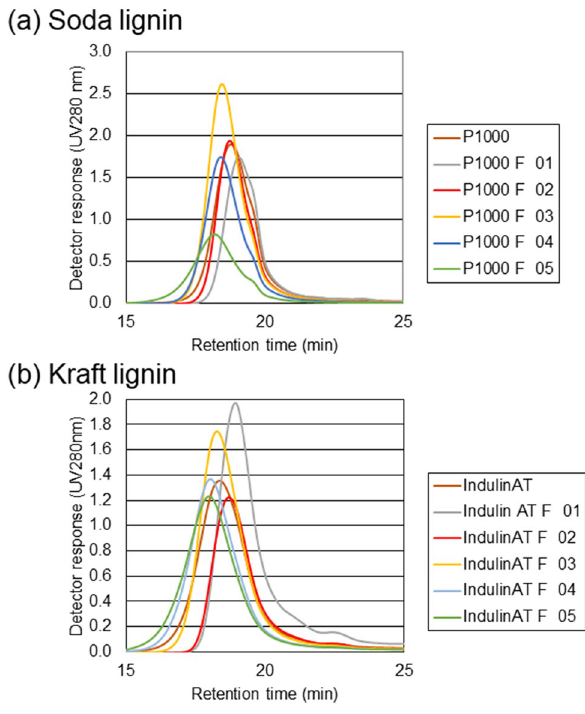
Figure 4. Alkaline SEC chromatograms of ( a ) P1000 soda lignin; and ( b ) Indulin AT Kraft lignin, and their solvent fractions (F01–F05). Alkaline SEC was undertaken as described in Methods and analysed to give M w , M n and polydispersity indices (Tables 2 and 3) according to ref 43 .